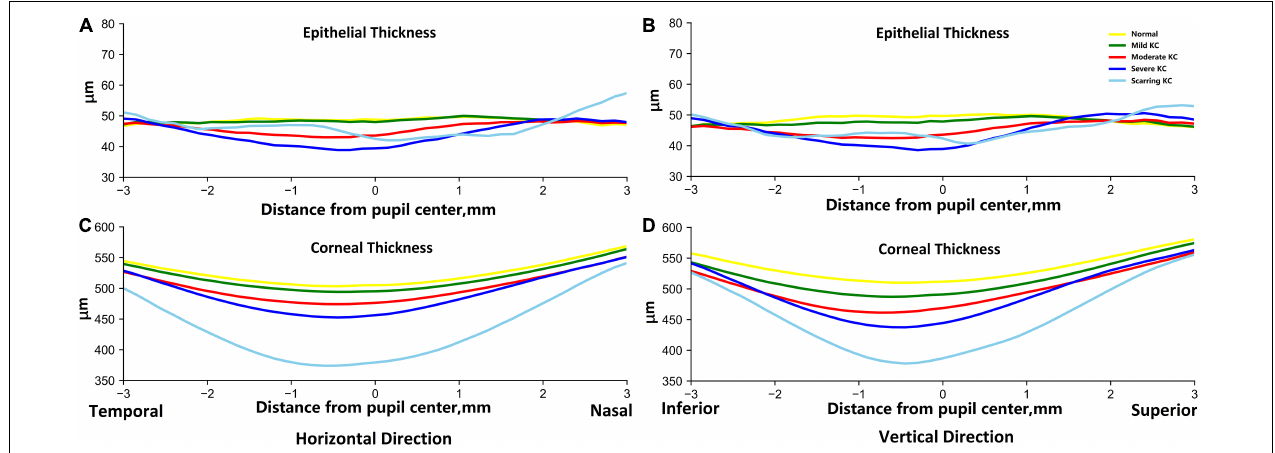
FIGURE 2 | The average epithelial and corneal thickness profiles in the horizontal (A,C) and vertical (B,D) meridians between the normal and KC eyes in different stages. The reference origin is the pupil center in the scanned AS-OCT image. The horizontal direction is from temporal to nasal, and the vertical direction is from inferior to superior. The yellow lines are for normal groups, and the green, red, dark blue, and sky-blue lines are for mild KC, moderate KC, severe KC, and scarring KC, respectively.